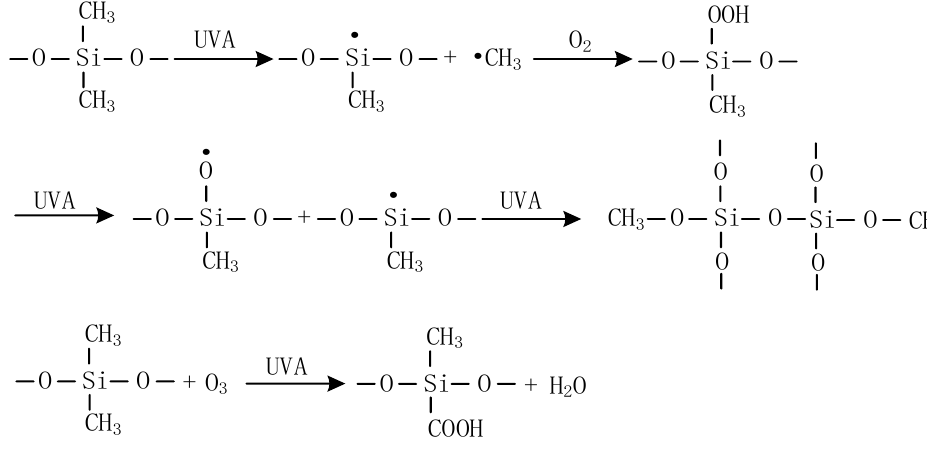
Figure 17. Proposed reactions of HTV silicone rubber during UV aging.